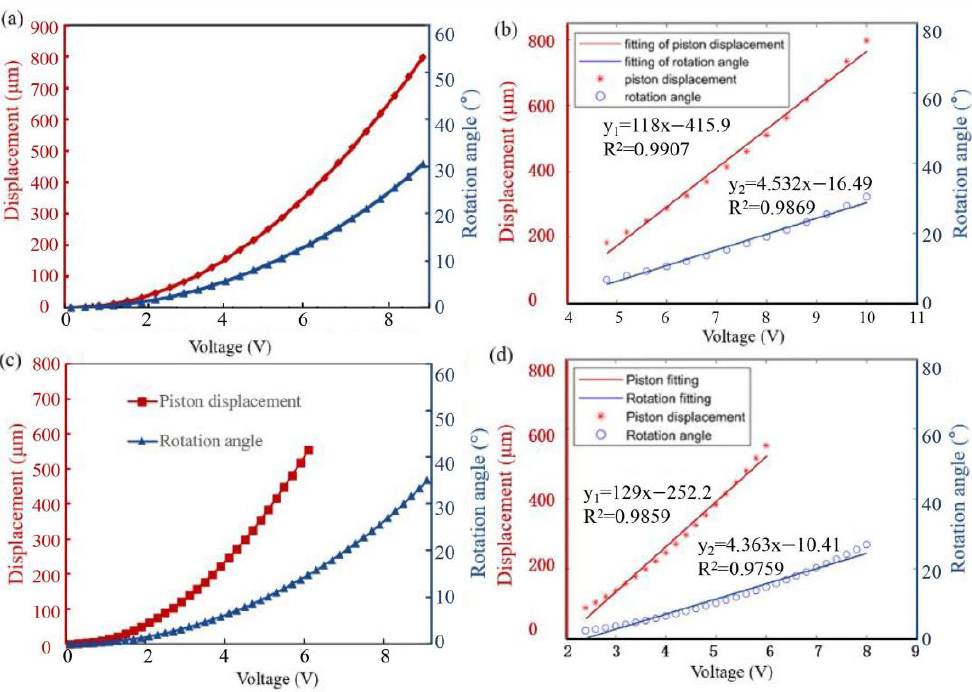
Figure 7. Stable state response. ( a , b ) “O” type. ( c , d ) “Z” type. ( a , c ) The steady curves. ( b , d ) Univariate Linear Fit to Data.